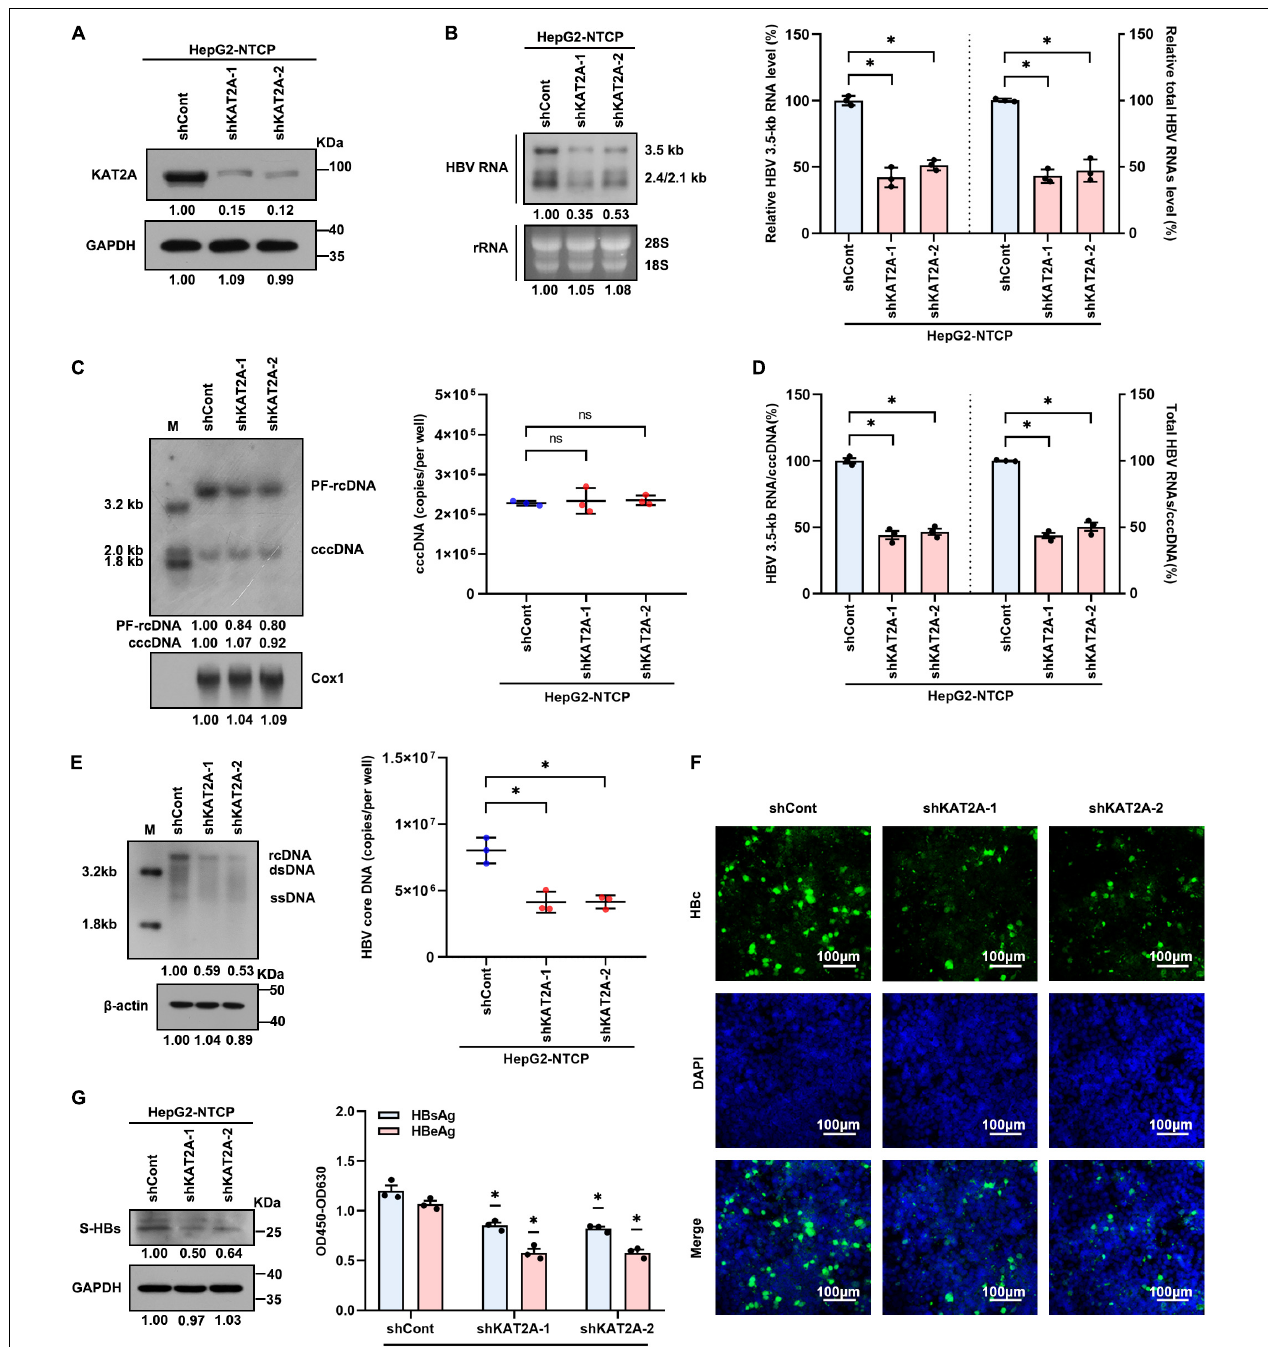
FIGURE 2 | KAT2A knockdown suppresses cccDNA transcription in the HBV infection cell model. HepG2-NTCP cells were infected HBV particles at 1-day post shRNA transduction. At 4 days after infection. (A) The expression of KAT2A was detected by western blot. (B) Northern blotting and real-time PCR were used to analyse the effect of KAT2A knockdown on HBV RNAs. (C) HBV cccDNA was extracted by a modified Hirt DNA extraction protocol and then Southern blotting and Taq-man probe qPCR were used to detect the HBV cccDNA level. The mitochondrial gene Cox1 was hybridised as the loading control for HBV cccDNA. (D) The level of HBV 3.5-kb RNA, total HBV RNAs, and cccDNA were used to calculate the ratio of HBV 3.5-kb RNA to cccDNA and total HBV RNAs to cccDNA. (E) HBV core DNA was quantified by Southern blotting and absolute quantification PCR. The level of β -actin was used as a loading control for HBV core DNA. (F) HBV core protein (HBc) was produced by HBV infected HepG2-NTCP cells. Intracellular HBc was visualised by immunofluorescence staining. The scale bar is 100 µ m. (G) Western blot was used to detect the level of HBsAg in cells (left). Cell culture supernatant was collected for HBsAg and HBeAg analysis via ELISA (right). Cox1, cyclooxygenase 1; rRNA, ribosomal RNA. * P <